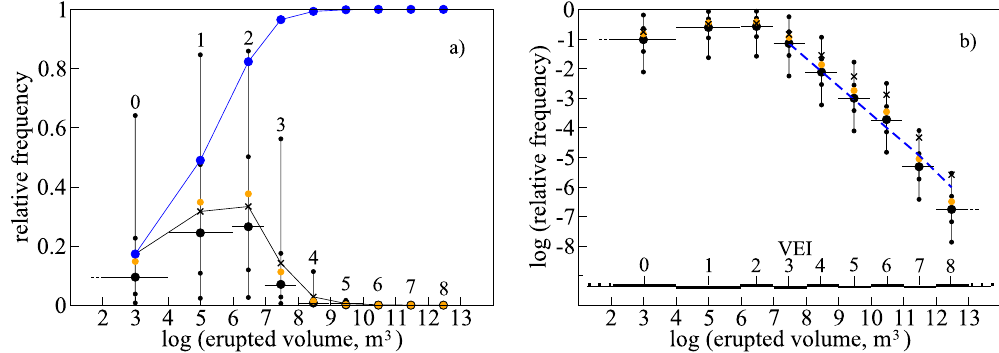
Figure 3. Relative frequencies of the different VEI class eruptions computed through MC simulation. For each VEI class (reported as a number above each distribution), the black circle represents the median of the MC distribution, and the smaller black circles represent the 50% and 90% confidence intervals; the x symbols represent the mean value after 5 million runs; the orange circles are frequencies directly obtained by the rate parameters λ in Table 2 (see Methods); and the blue circles are the cumulative of the mean values. The horizontal bars extend to cover the range of erupted volumes corresponding to each VEI class (Table 1). ( a ) Linear frequency axis. ( b ) Logarithmic frequency axis highlighting a power law (straight line) distribution of explosive eruption frequencies equal to or larger than VEI 3 (blue dashed line). The computed power law exponent is 1.95, with p-value = 0.65 providing statistical robustness to the power law hypothesis (see